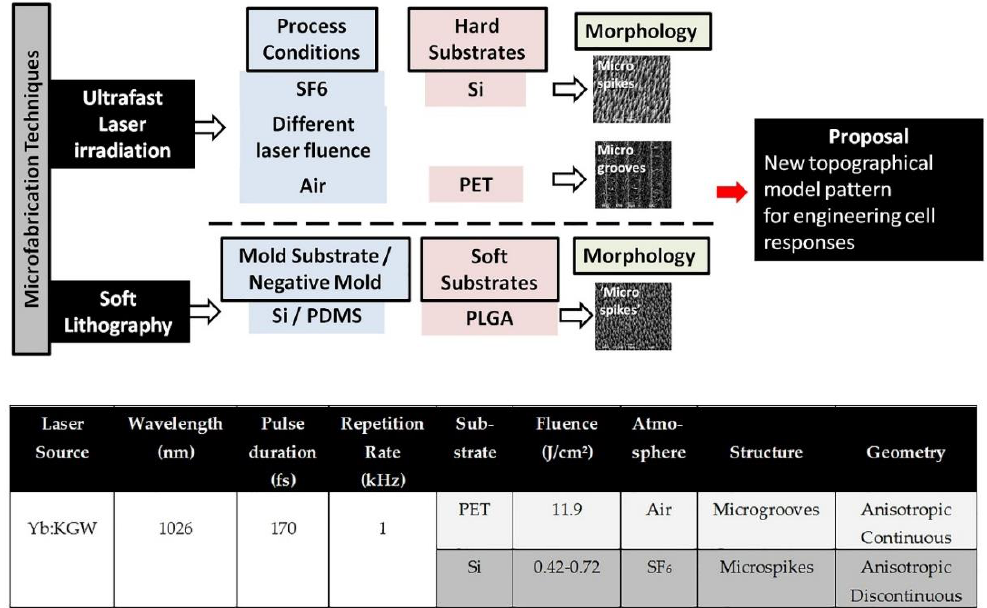
Figure 11. Comparison of the microfabricating techniques used in this study to fabricate the laser-microstructured substrates; the table demonstrates the conditions of the ultrafast laser irradiation process.